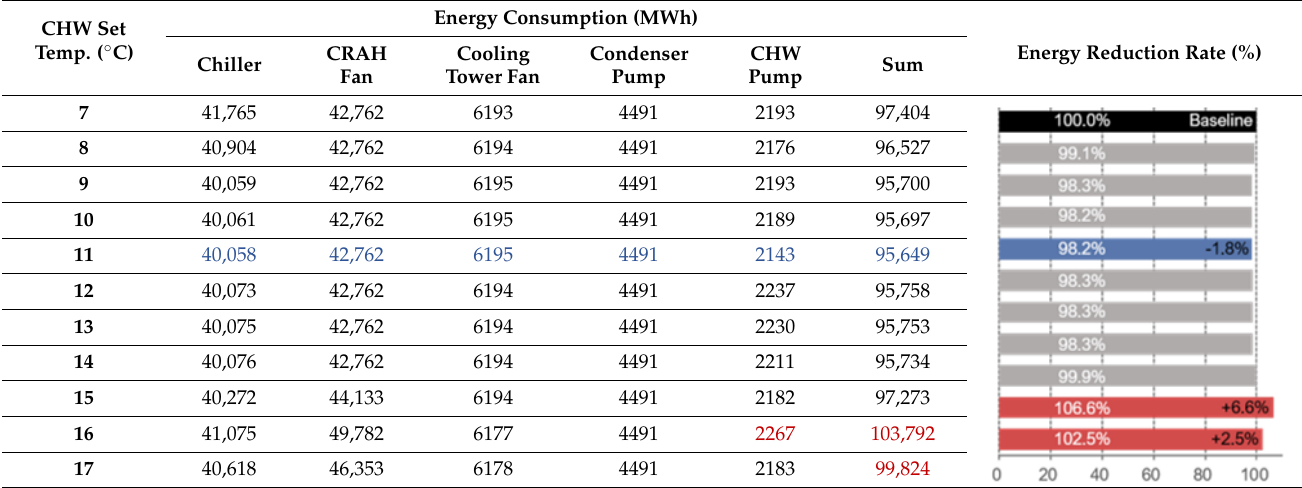
Table 3. Variation of energy consumption of equipment with changes in the chilled water set temperature of the central cooling system (type 2). Values marked in red indicate increased energy consumption compared to 7 ◦ C. The value shown in blue indicates the optimum value among the set temperature of chilled water in the range of 7–17 ◦ C. CHW Set Temp. ( ◦ C)